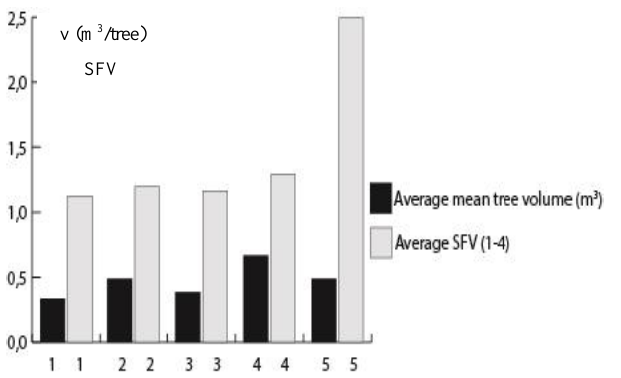
Figure 3. Average mean tree volume (v ̅) and SFV data of 35-year-old black locust cultivars as a mean of